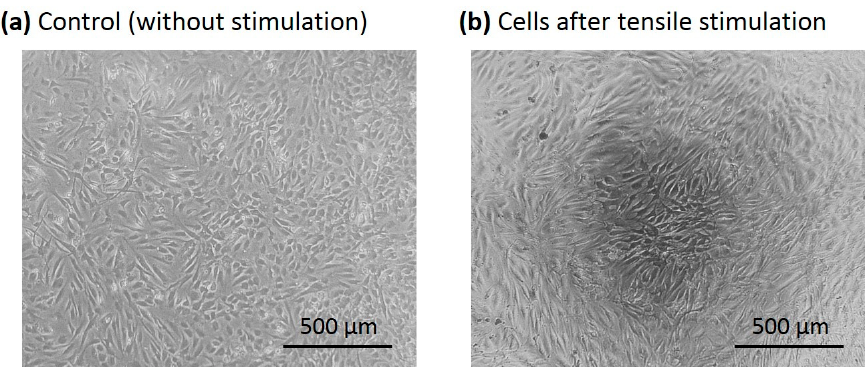
Figure 8. Microscopic images of the ADSCs. ( a ) Control group (without stimulation). ( b ) The cells stimulated by multi-axial tensile strain for three days.